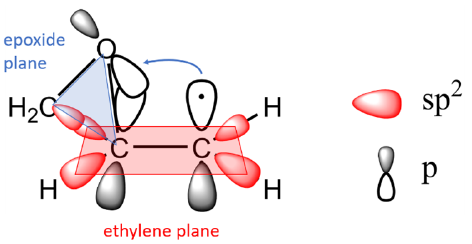
Figure 4. Involvement of sp 2 -type orbitals in the epoxide